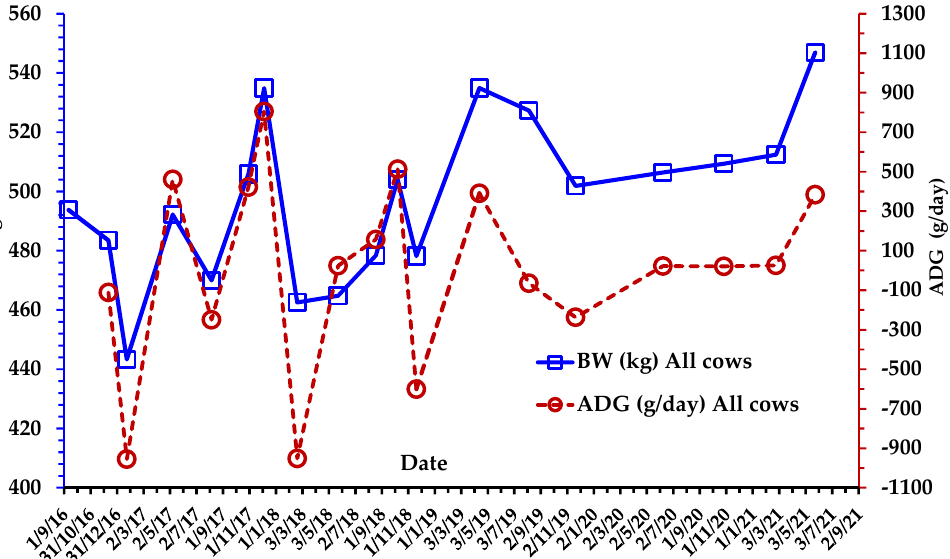
Figure 2. The studied cows’ body weight (BW, kg, □ ) and average daily gain (ADG, kg/day, o). Dates are given as day/month/year.